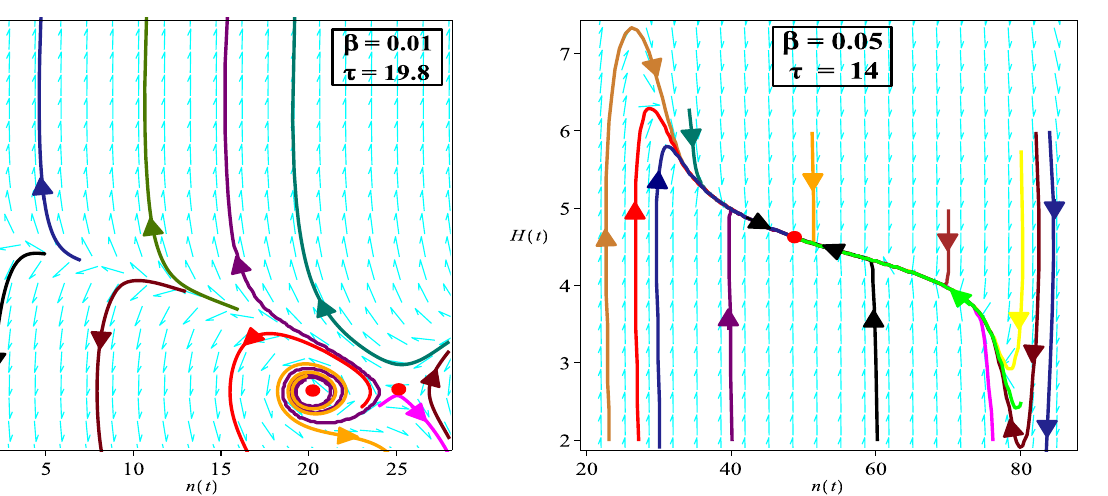
(c) Continuation of Figure 7b. In addition to the saddle at ( n ∗∗ , H ∗∗ = β 1 / (1 − α ) ), where H ∗∗ = 4 . 64 and n ∗∗ = ˆ ν ∗∗ 0 = 0 . 56, there are two critical points of the type ( n ∗ , H ∗ = 0): at n ∗ 1 = 20 . 11 and at n ∗ . 04. The first of these, n ∗ . 11, is to 2 = 25 1 = 20 the left of n ∗ = ( 3 / 2 − 1) /A = 22 . 48 where the eigenvalues are purely imaginary and, as seen by the centre manifold theory, the trajectories are unstable spirals. The second one, n ∗ 2 = 25 . 04, is to the right of n ∗ = 22 . 48 where the eigenvalues are both real and with opposite signs, thus this critical point is a sad- dle. Such “dipole” of unstable spirals and a saddle is always a present feature when τ < τ = 19 .